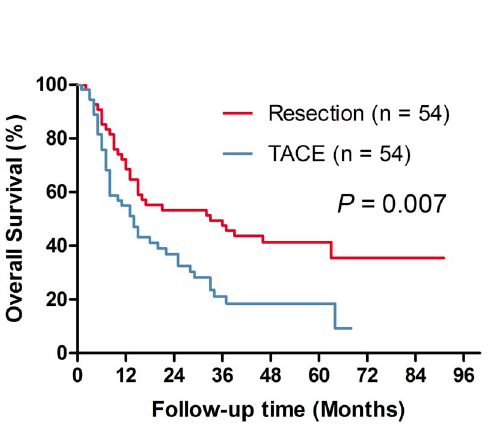
Fig. 2. Overall survival curves for the liver resection (LR) group and the transarterial chemoembolization (TACE) group after propensity score